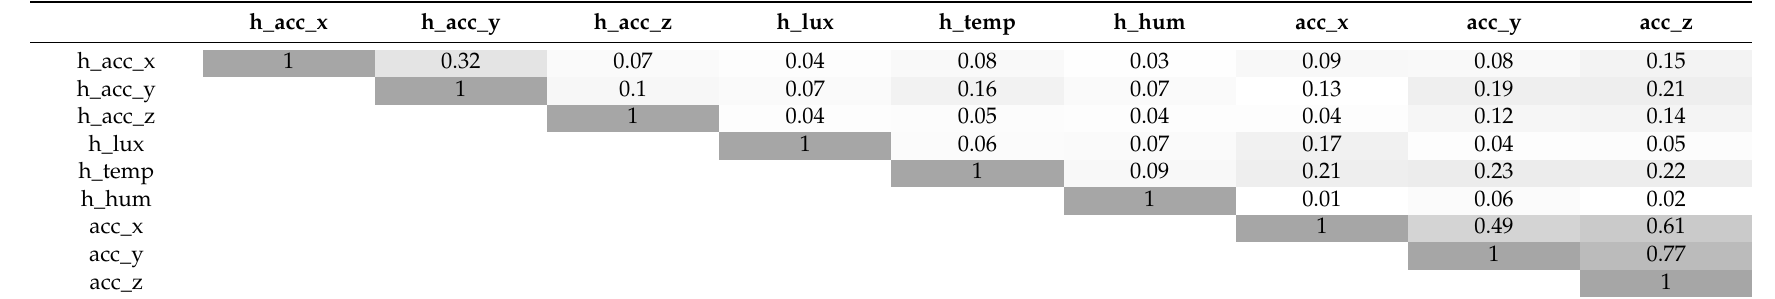
Table 2. Correlation matrix of